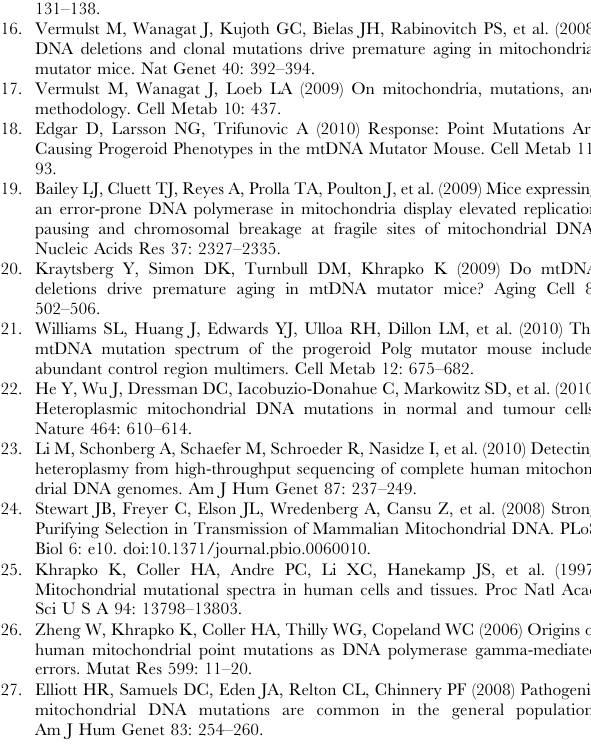
Table S5 Large deletions ( . 10 bp) observed in the samples by the SplitSeek method.